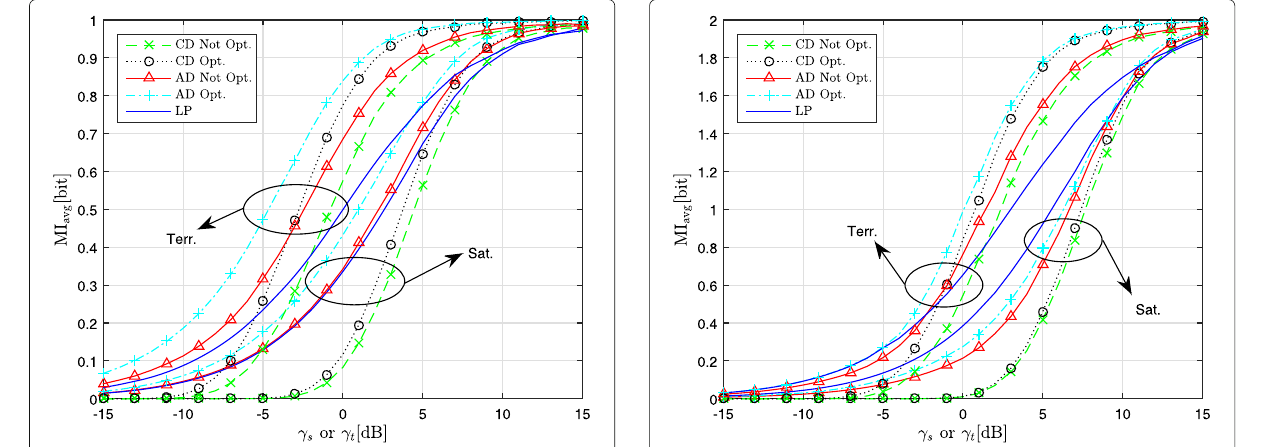
Fig. 7 Performance of CD, AD, and LP for 4-QAM on terrestrial and satellite channel